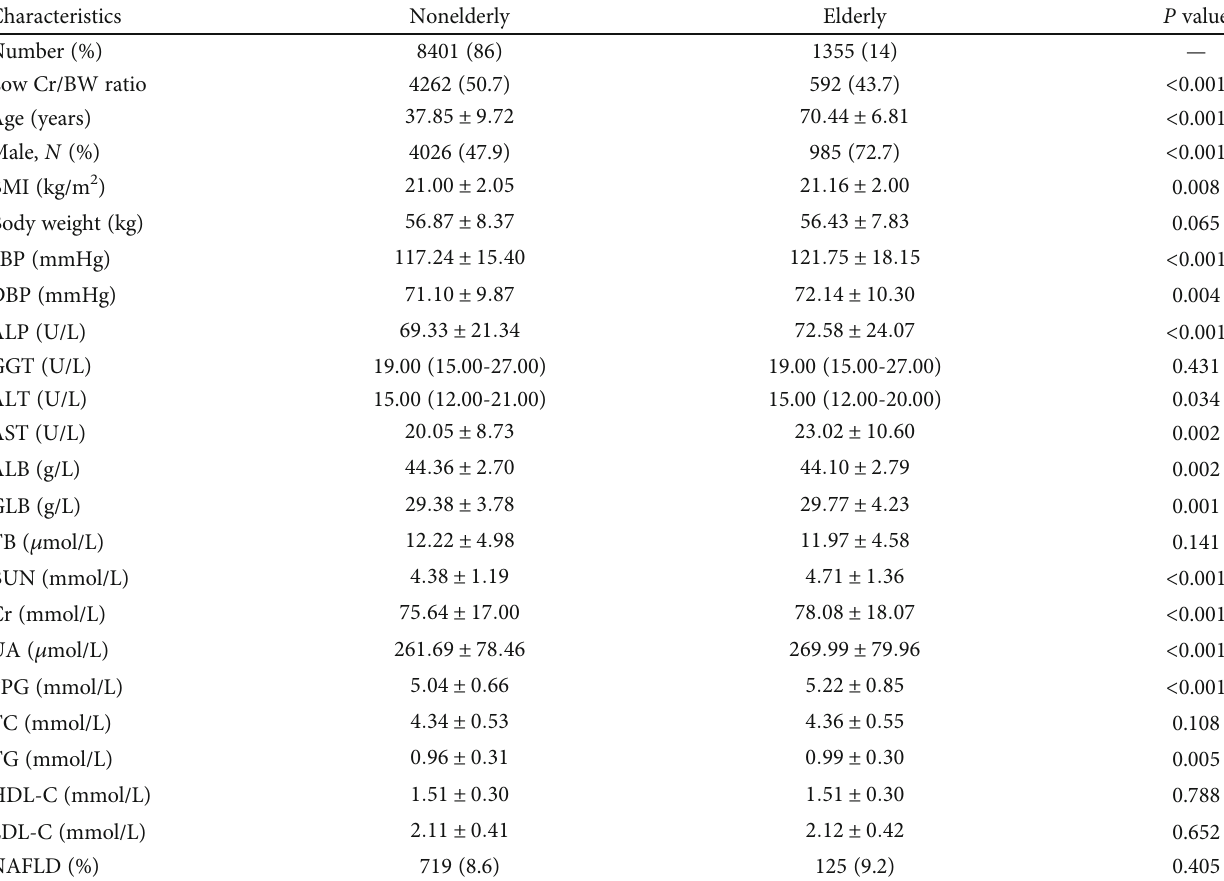
Table 2: Baseline characteristics of 9756 participants strati fi ed by age.